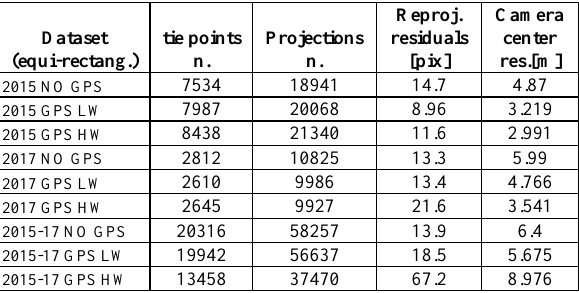
Table 2. Equirectangular dataset: stats on collinearity residuals. Dataset (equi-rectang.) GCP CP